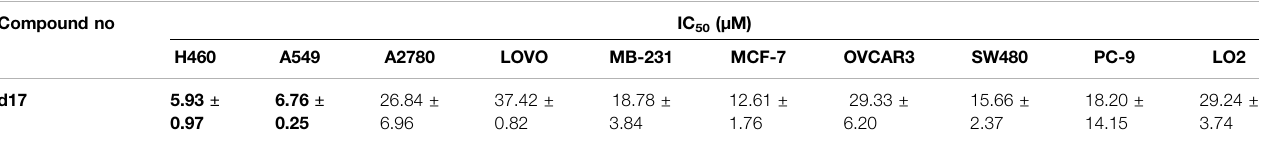
IC 50 values were obtained from three independent experiments. These results are reported as the average ± SD.